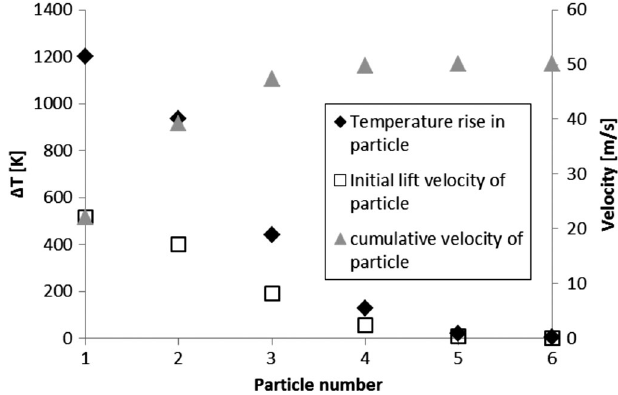
FIG. 9. Temperature jump and corresponding lift velocity of an idealized stack of